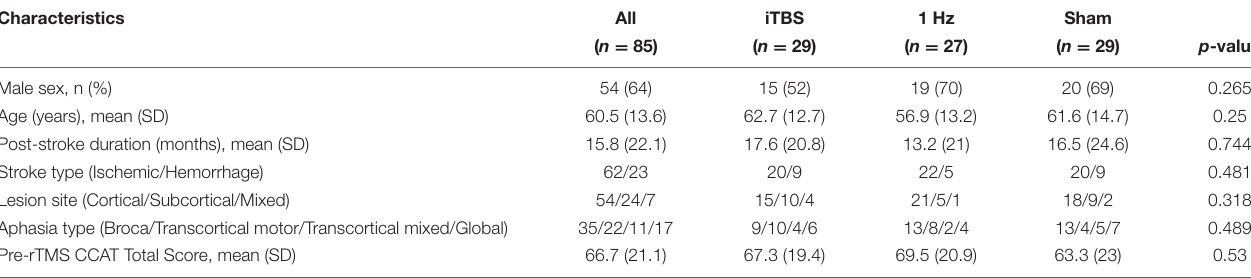
TABLE 1 | Demographic data and clinical variables of participants. Characteristics